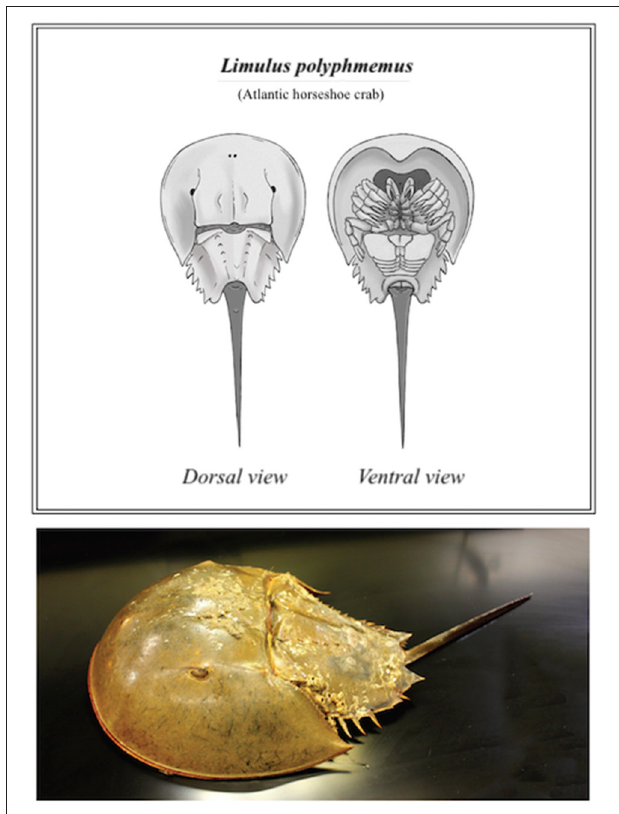
FIGURE 1 | Basic anatomy of the horseshoe crab ( L. polyphemus ) (Top) ; and photograph of a mature female (Bottom)